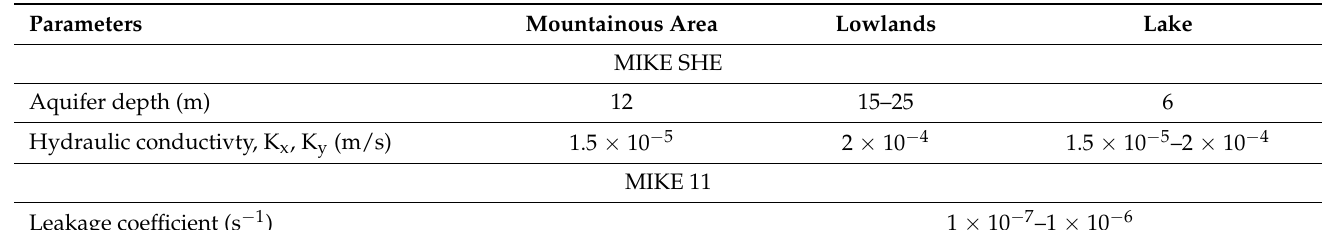
Table 4. Final values of calibrated parameters in the coupled MIKE SHE/MIKE 11 hydrological model of Lake Zazari